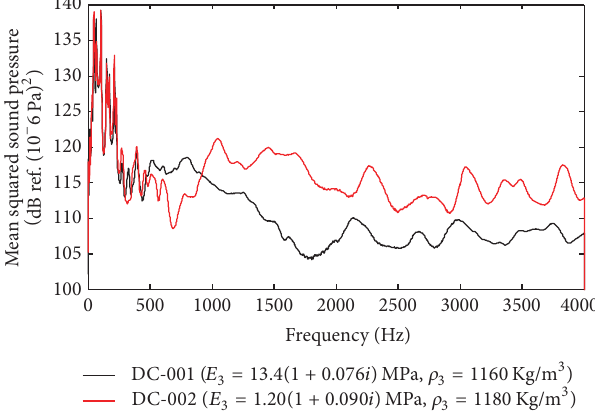
Figure 13: Sound pressure radiated by the two